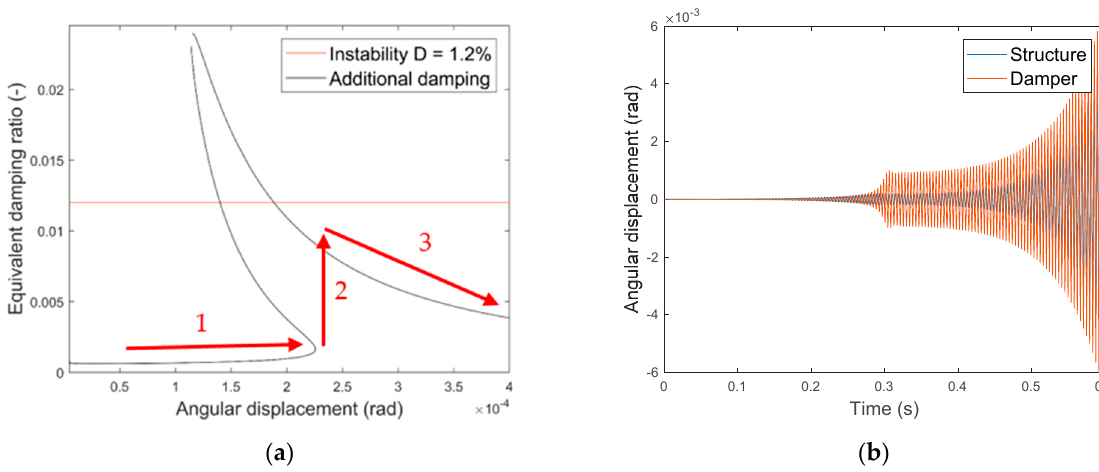
Figure 13. Damper with a cubic nonlinear stiffness ( α = 7 · 10 11 Nm , d = 50 Nm and an instability of D = − 0.8% ( a ) Equivalent damping ratio regarding the angular displacement of the drill string structure. ( b ) Angular displacement of the drill string structure and the damper.